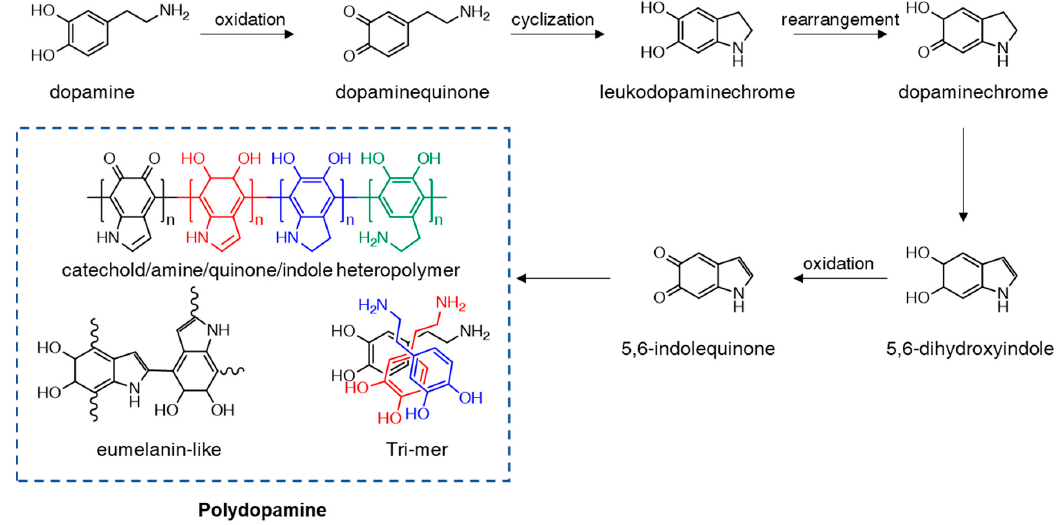
Figure 2. Schematic illustration of the polymerization of dopamine into polydopamine under the alkaline condition. alkaline